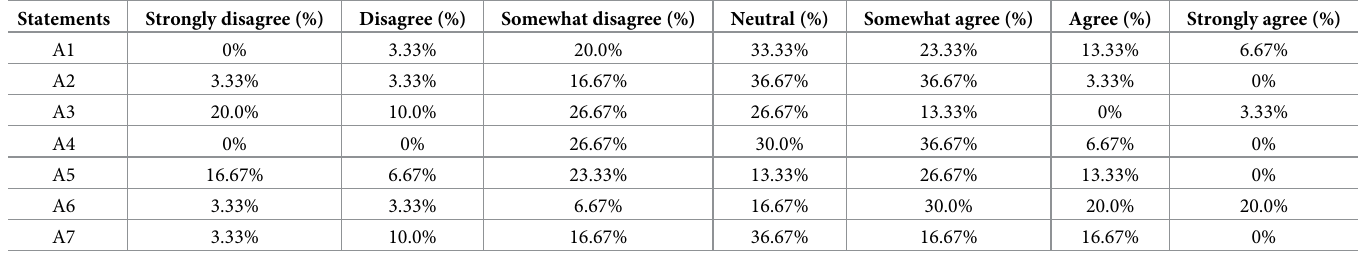
Table 4. Distribution scores for restaurant